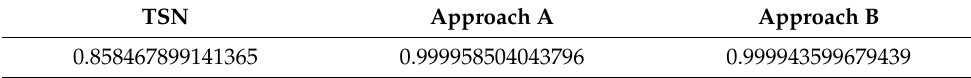
Table 4. Reliability of TSN, approach A and approach B in the case of